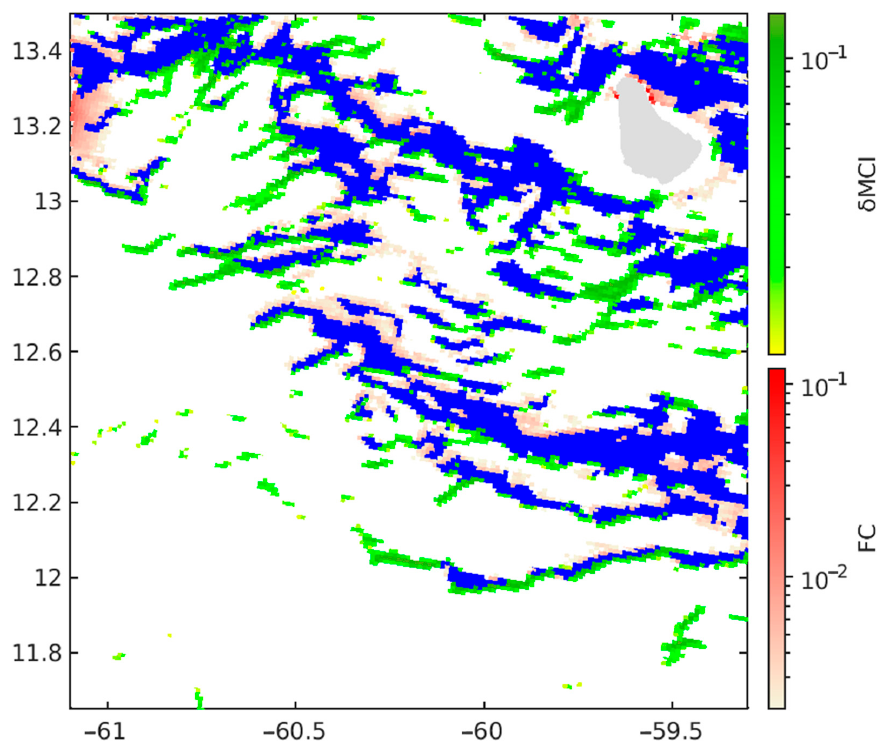
Figure 9. Superposition of Sargassum detections from MODIS with the ID method and OLCI with the CNN method ( δ MCI): detected with both MODIS and OLCI (blue), detected with OLCI but not with MODIS (green) and detected with MODIS but not with OLCI (red). Terra and OLCI images from 29 January 2019 at 14:35 UTC and 13:38 UTC respectively.